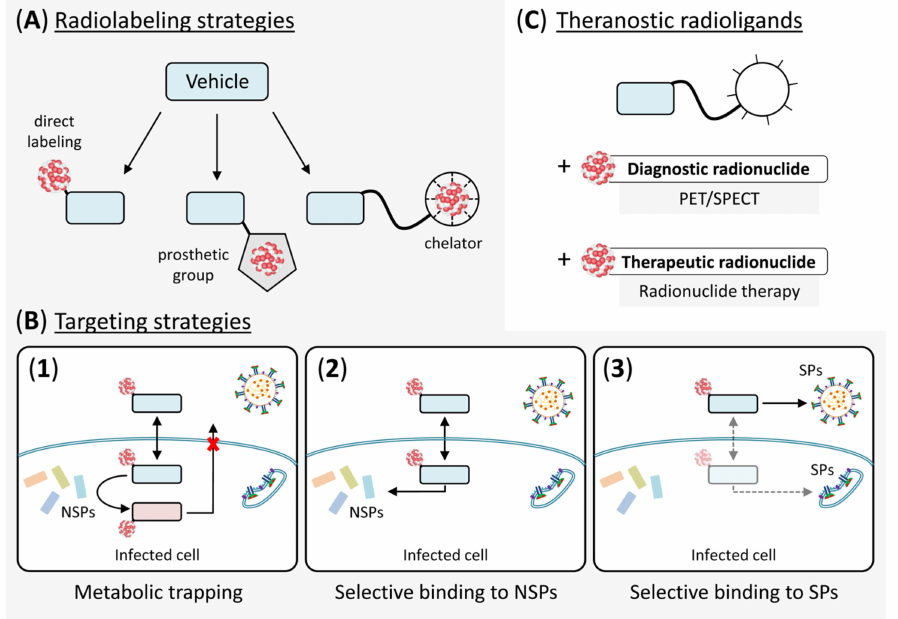
Figure 11. Radiolabeling and targeting strategies for virus-specific imaging and / or radionuclide therapy. ( A ) Coupling of radionuclides to a suitable vehicle for delivery to the target structures can be achieved through direct radiolabeling of the vehicle (left), by conjugation of the vehicle with radiolabeled prosthetic groups (middle) or by conjugation of the vehicle with a chelator for radiometal complexation (right). ( B ) Delivery of radionuclides to virus-infected cells and / or the free virus could be achieved with ( 1 ) vehicles that are metabolized by virus-encoded non-structural proteins (NSPs) and selectively retained in infected cells, ( 2 ) vehicles that selectively bind to virus-encoded NSPs in infected cells or ( 3 ) vehicles that selectively bind to virus-encoded structural proteins (SPs) on the free virus and (for vehicles that can cross the cell membrane) in infected cells. ( C ) Theranostic radioligands are usually based on conjugation of a vehicle with a chelator for complexation of either diagnostic or therapeutic radiometals, allowing for application of the same conjugates for imaging and radionuclide